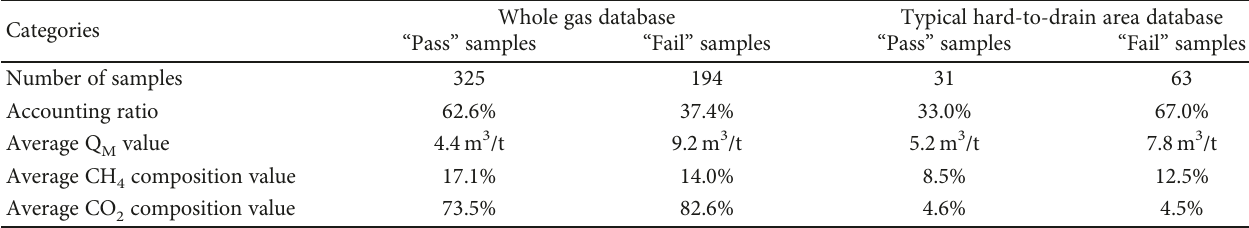
Table 4: Test results of the whole gas database and typical hard-to-drain area database.